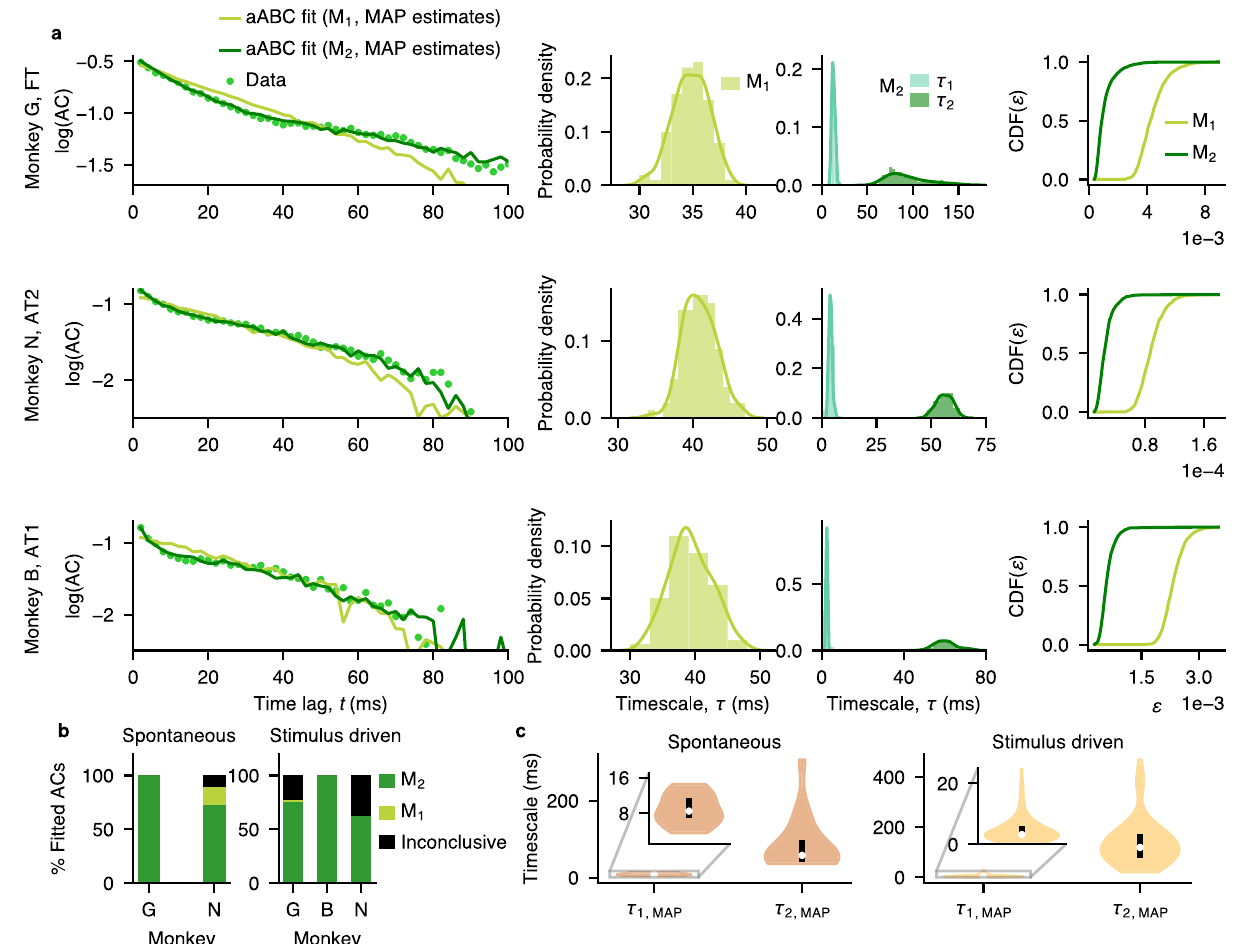
Fig. 2 | Two timescales in ongoing spiking activity within V4 columns. drivenactivitywerebetterdescribedwithtwodistincttimescales(M 2 )thanasingle a Comparison between the two-timescale (M 2 ) and one-timescale (M 1 ) generative timescale (M 1 ). For a few fi ts the model comparison was inconclusive as the models for three example recording sessions (rows). The models were fi tted to observed statistics were insuf fi cient to distinguish between the models. The total autocorrelations of V4 spiking activity using the adaptive Approximate Bayesian number of fi tted autocorrelations for each monkey (G, N, B)was N G =5, N N =18 for Computations(aABC).The shape of the neural autocorrelation (AC) is reproduced spontaneous, and N G =57, N N =24, N B =39 for stimulus-driven activity. c MAP esti- by the autocorrelation of synthetic data from the two-timescale model with the mates for the fast and slow timescales were heterogeneous across recording ses- maximum a posteriori (MAP) parameters, but not by the one-timescale model (left sions during spontaneous and stimulus-driven activity. Violin plots show the panels). Autocorrelations are plotted from the fi rst time-lag ( t =2ms). Marginal distributionsof timescalesfortheautocorrelationsthatwerebetter fi ttedwithtwo posterior distribution of the timescale ( τ ) estimated by fi tting M 1 is in between the timescales. The distributions were smoothed with Gaussian kernel densities. The posteriordistributionsoftimescales( τ 1 , τ 2 )estimatedby fi ttingM 2 (middlepanels). white dot indicates the median, the black box is the fi rst to third quartiles. Inset ð ε Þ betweentheautocorrelationsofV4data shows a zoomed range for the fast timescale. Number of autocorrelations better CumulativedistributionoferrorsCDF M i fi ttedautocorrelations: N =18/23duringspontaneous fi ttedwithM and synthetic data generated with parameters sampled from the M 1 or M 2 pos- 2 outofthetotal teriors (right panels). M 2 is a better fi t since it produces smaller errors (i.e. Bayes activity, N =92/120 during stimulus-driven activity. Source data are provided as a ð ε Þ = CDF M ð ε Þ >1,Methods).FT- fi xationtask,AT-attentiontask. b In factor =CDF M Source Data fi 2 1 most recording sessions, the autocorrelations during spontaneous and stimulus-